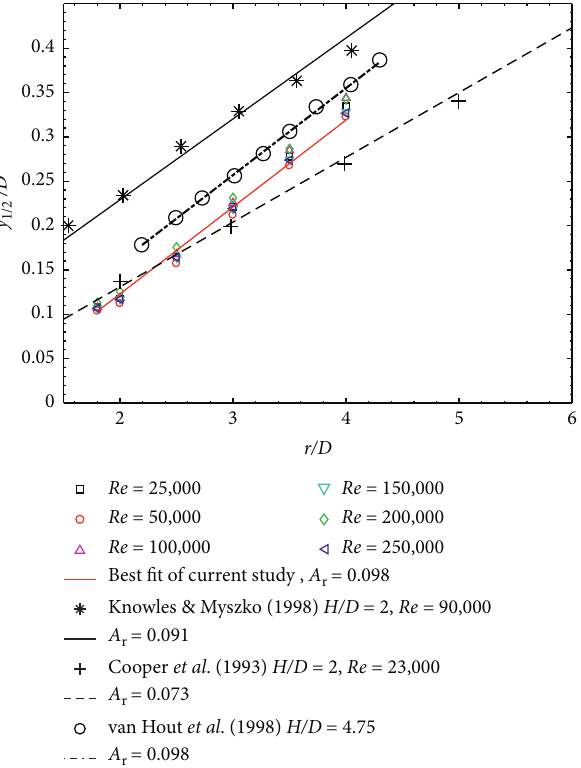
Figure 17: Variation of the growth rates for different Reynolds numbers.